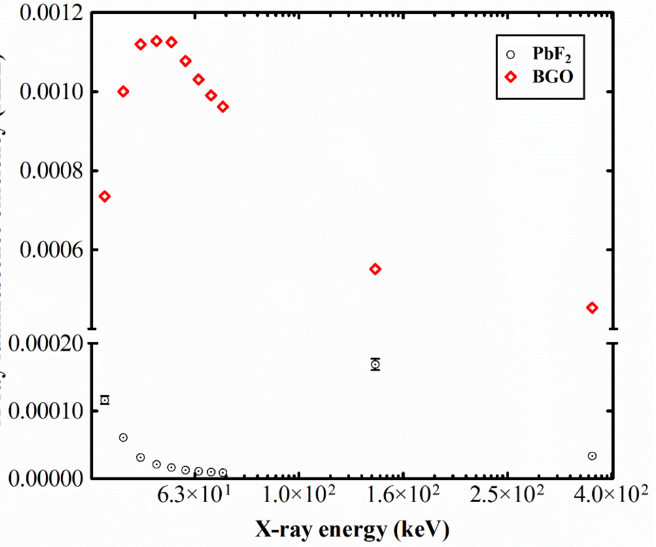
Figure 6. X-ray luminescence efficiency of PbF 2 and BGO crystals in the X-ray (42–71 keV) and nuclear medicine (140 keV Tc-99m, 365 keV I-131) energy